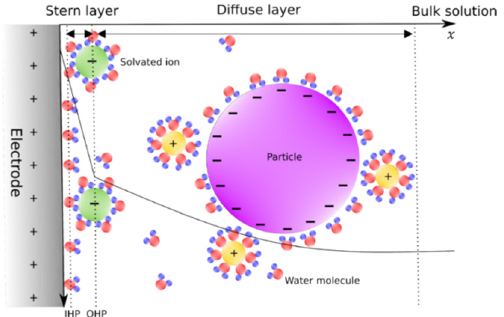
Figure 1. EDL on a charge surface according to the Gouy–Chapman–Stern model.